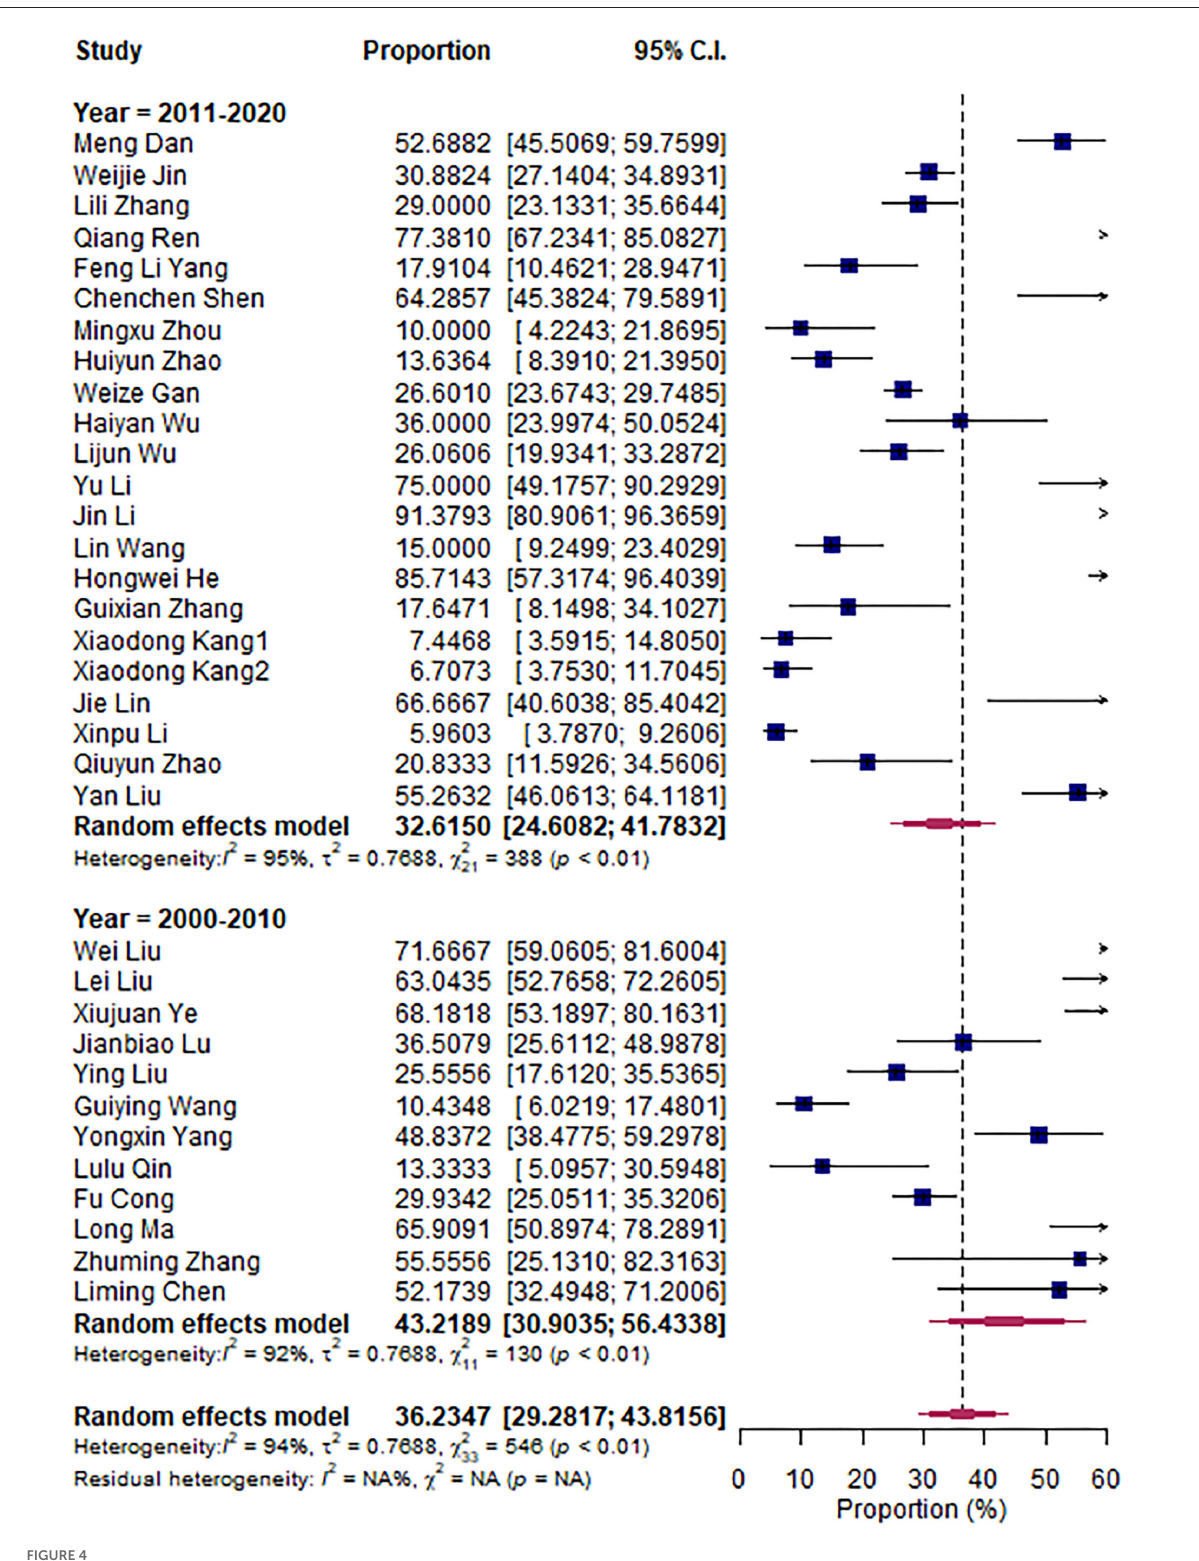
FIGURE4 Overall prevalence subgroup by